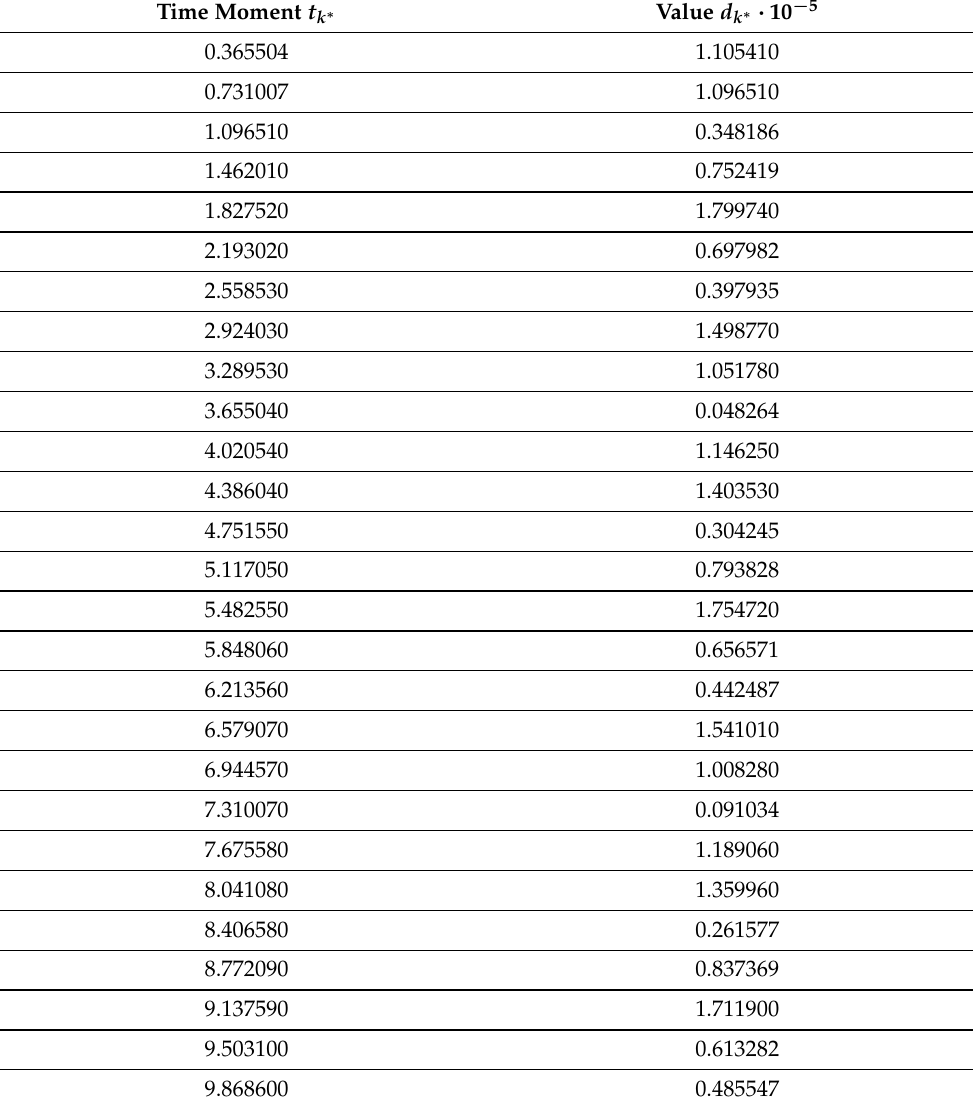
Table 3. The Poincaré recurrences for the point (10), ∆ t P = 10 − 6 , T = 40 for reaching the attractor. Time Moment t k